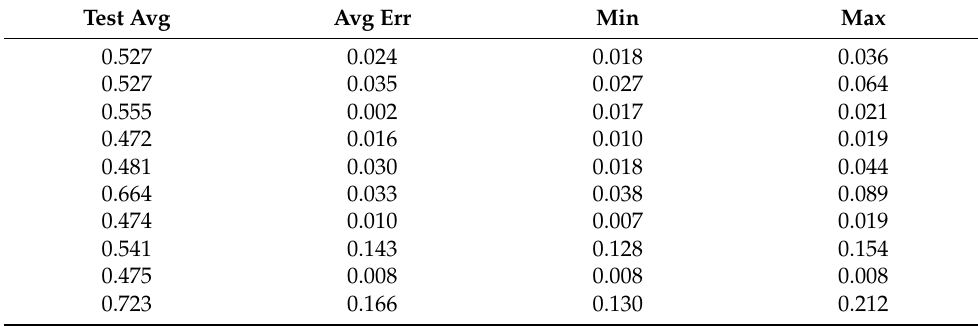
Table A52. Set 1, trials 31–40 data (actual PR value).